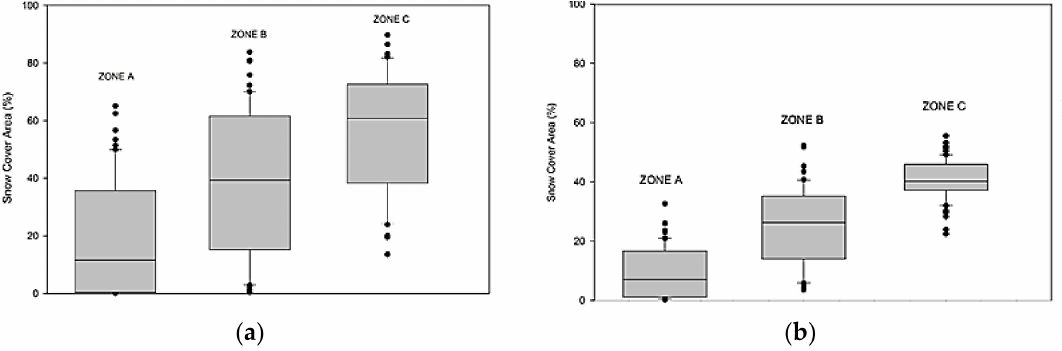
Figure 8. The box-plot shows the interannual variability in snow-covered area of the ( a ) Astore and ( b ) Hunza River basin, in three altitudinal zones over a 15-year period